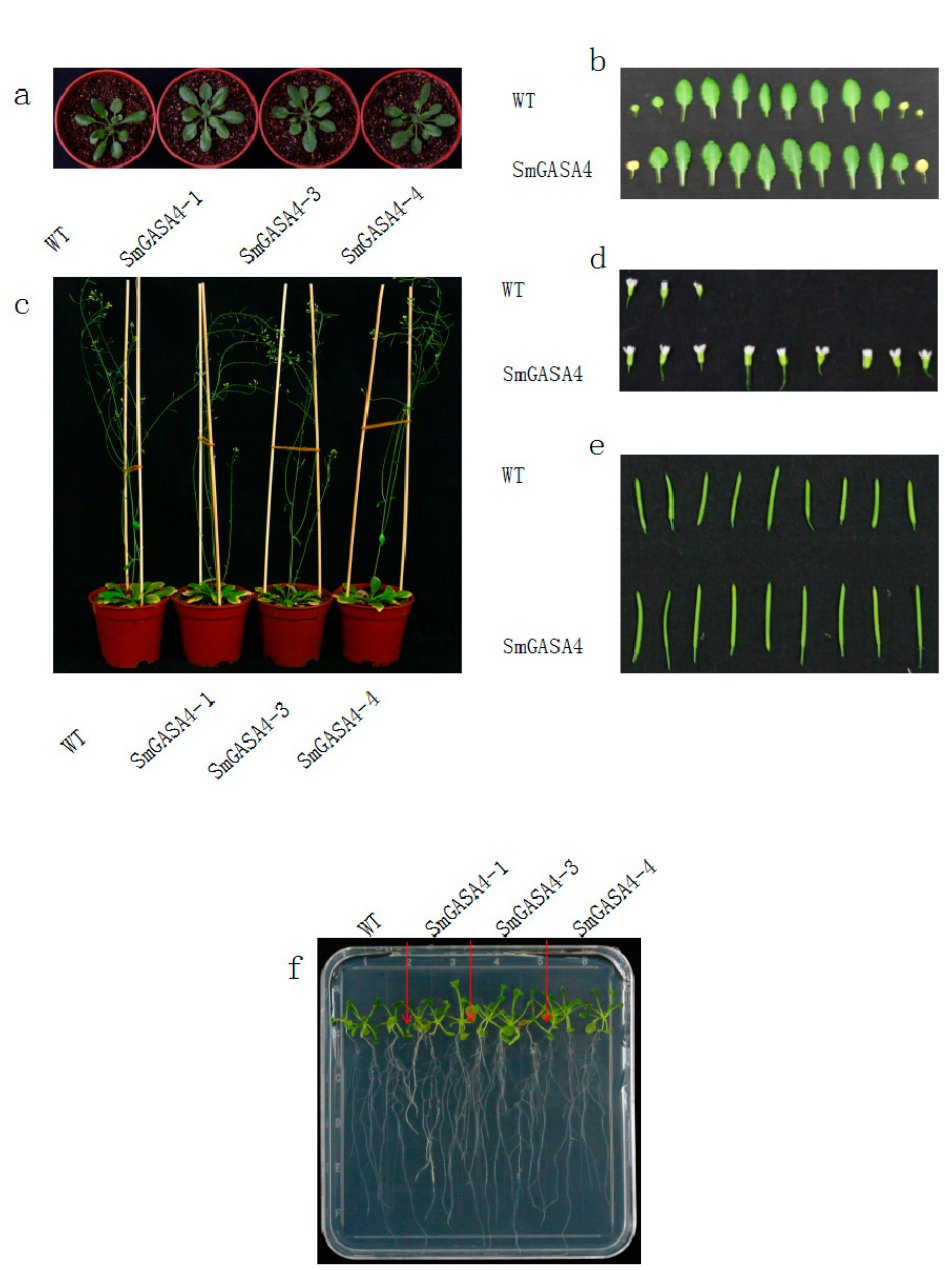
Figure 6. SmGASA4 Arobidopsis phenotypic observations, as follows: ( a ) 12 leaflet old Arobidopsis , ( b ) WT and SmGASA4 leaves, ( c ) ripe period old Arobidopsis , ( d ) WT and SmGASA4 flowers, ( e ) WT and SmGASA4 capsules, ( f ) WT and SmGASA4 roots.